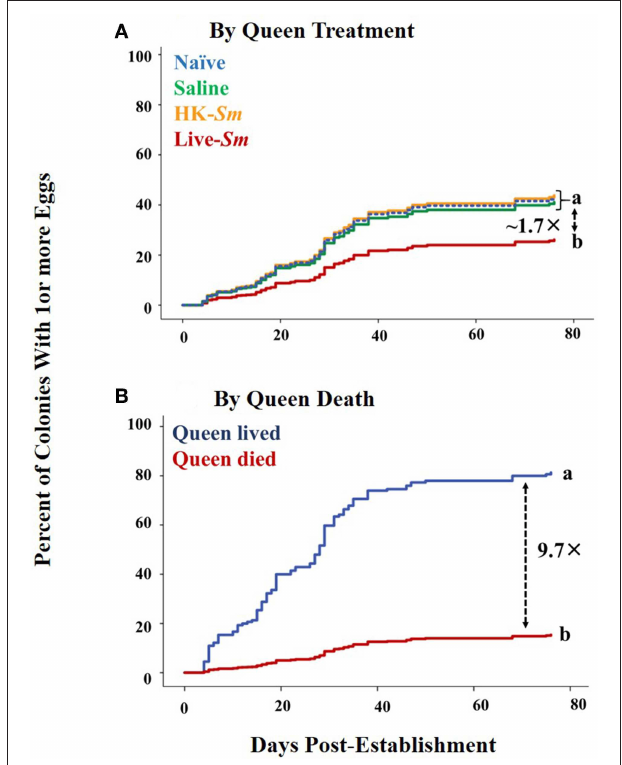
FIGURE 4 | Likelihood of oviposition across the first 80 days post-establishment (Cox models). (A) Likelihood of oviposition as a function of queen treatment. Of the established 271 incipient colonies, only 120 (44.3%) oviposited at least one egg within the first 80 days post-pairing ( n = 45 colonies headed by naïve queens + naïve kings; n = 22 by saline queens + naïve kings; n = 26 by HK- Sm queens + naïve kings; n = 27 by live- Sm queens + naïve kings). (B) Likelihood of oviposition as a function of queen death. Differing letters denote statistical significance. Dashed arrow with corresponding number indicate how many times greater the likelihood of oviposition is between significant pairwise